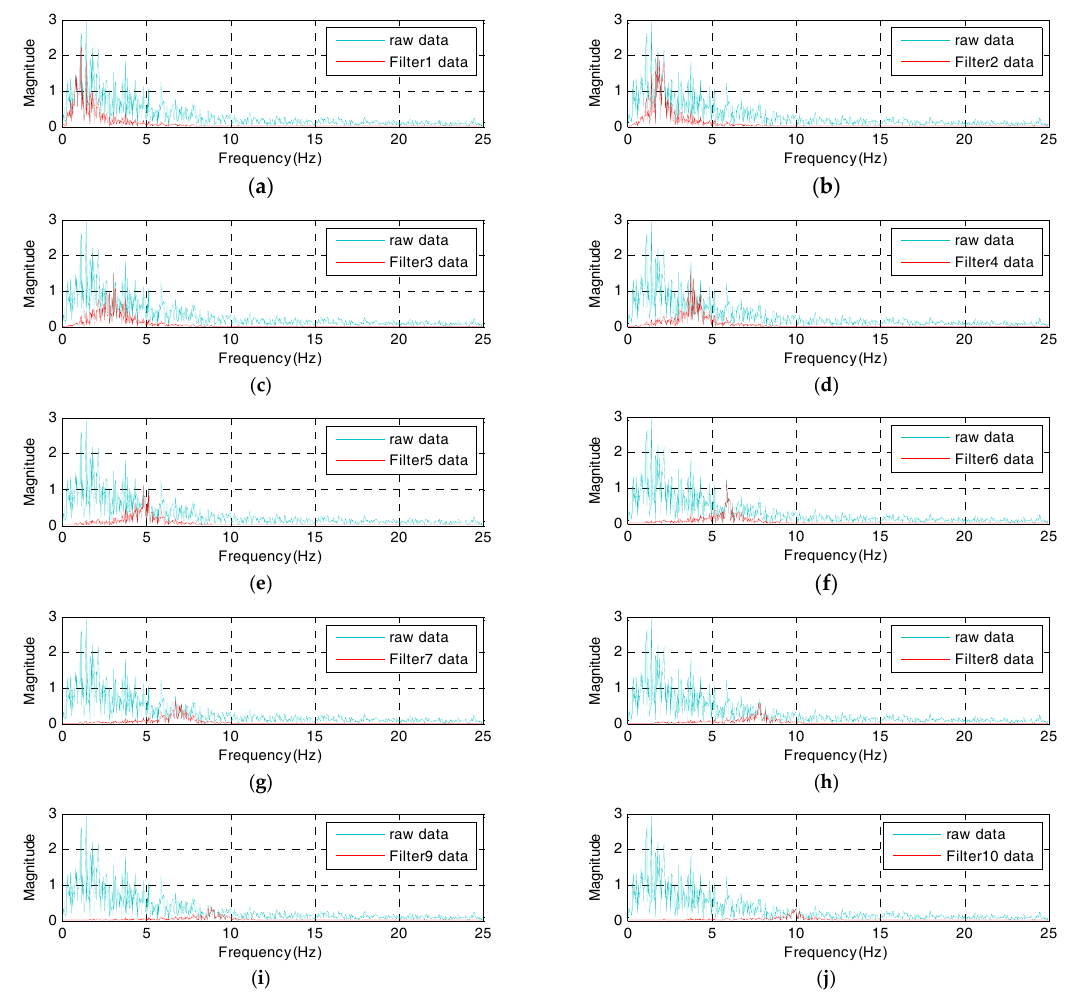
Figure 11. Frequency domain responses of optimal condition AFB: ( a ) filter 1 data; ( b ) filter 2 data; ( c ) filter 3 data; ( d ) filter 4 data; ( e ) filter 5 data; ( f ) filter 6 data; ( g ) filter 7 data; ( h ) filter 8 data; ( i ) filter 9 data; ( j ) filter 10 data.